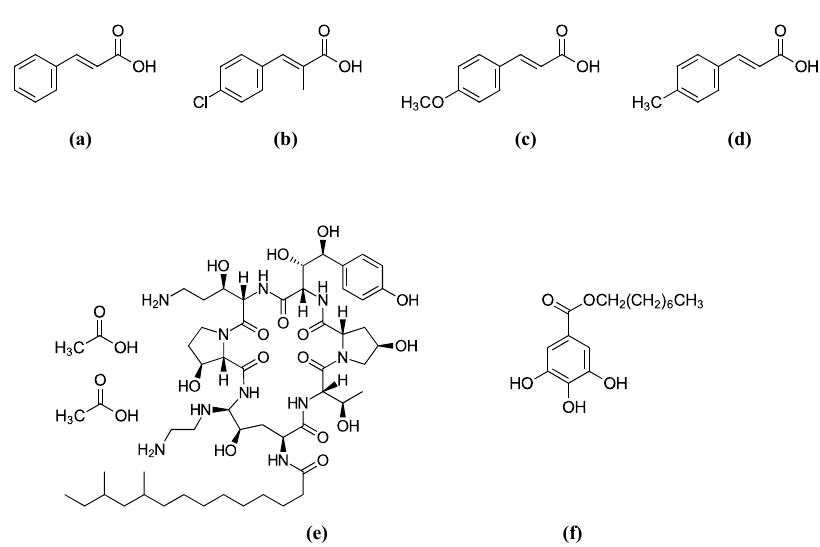
Figure 1. Structures of antifungal agents used in this study. ( a ) Cinnamic acid (Basic structure), ( b ) 4-Chloro- α -methylcinnamic acid, ( c ) 4-Methoxycinnamic acid, ( d ) 4-Methylcinnamic acid, ( e ) Caspofungin (CAS), ( f ) Octyl gallate (OG).